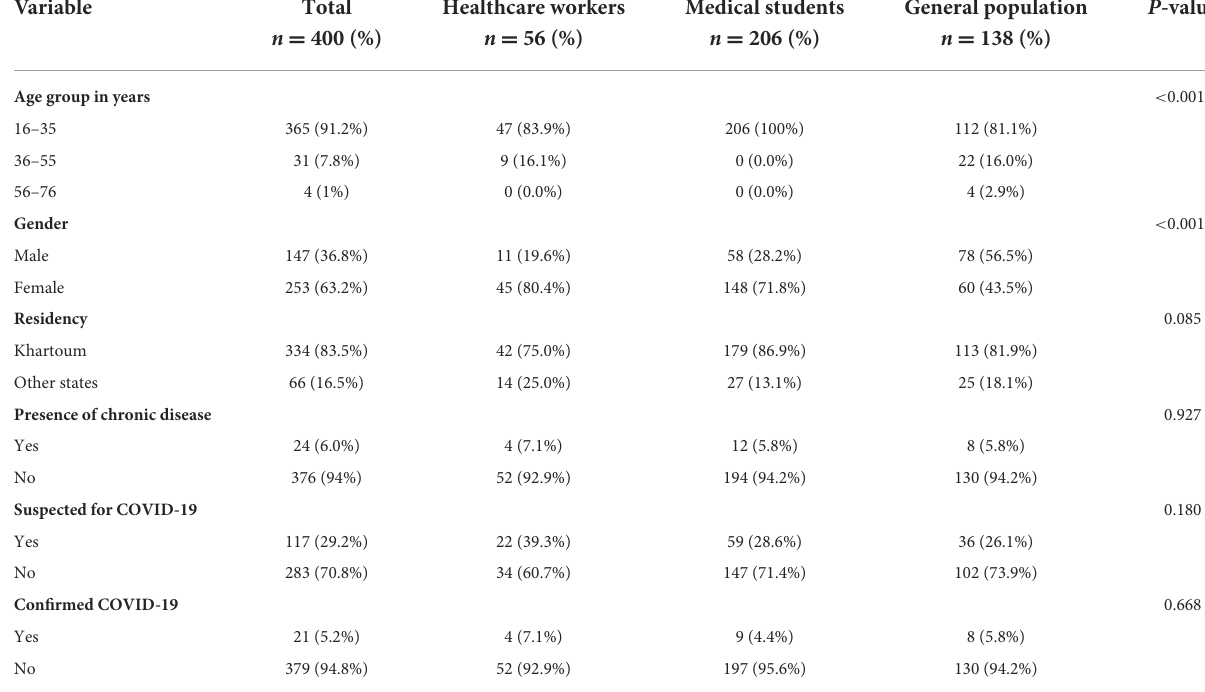
TABLE 1 Sociodemographic characteristics of the participants.